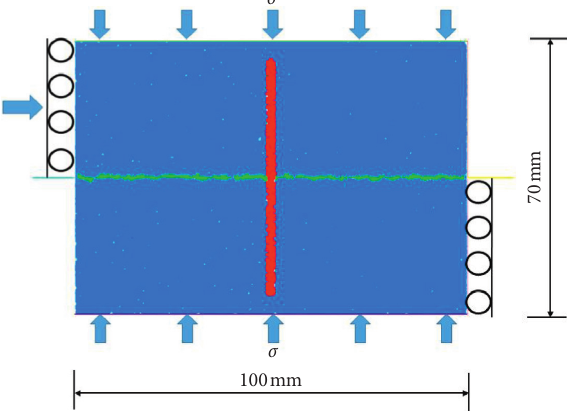
Figure 1: Numerical